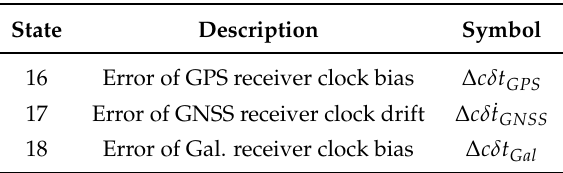
Table 3. Receiver Clock States of the Multi-GNSS